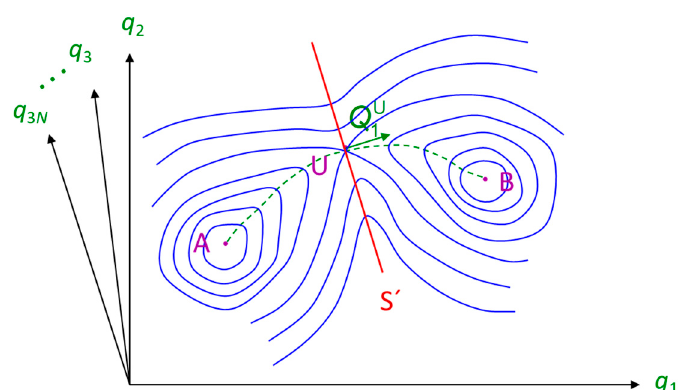
Figure 4. Trajectory, in 3 N dimensional coordinate space q , that passes from one basin to another, crossing a (3 N -1) dimensional “dividing surface” separating the two basins. Solid lines correspond to a (3 Ν -1)-dimensional hypersurface of constant energy 𝑉 , Q (cid:2869)(cid:2905) is the coordinate along the negative curvature of 𝑉(𝒒) (reaction coordinate) and S′ is a (3 Ν -1)-dimensional hypersurface normal to the reaction coordinate, constituting the dividing surface between the states A and B.